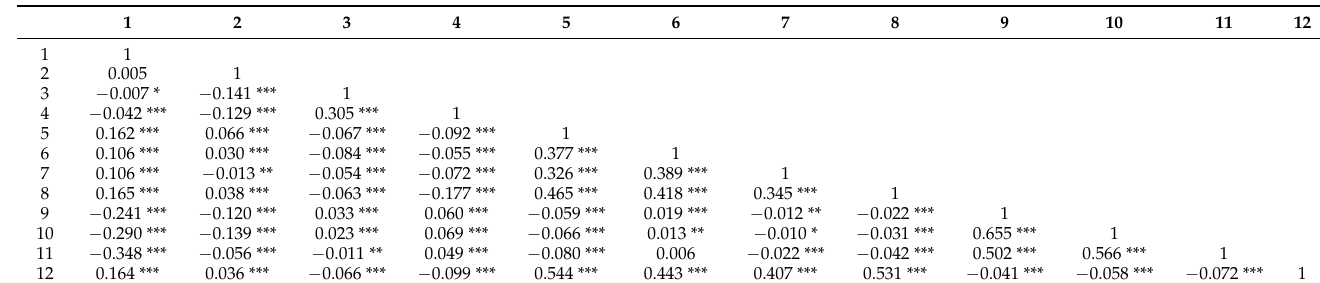
Table 2. Correlations among the study variables.